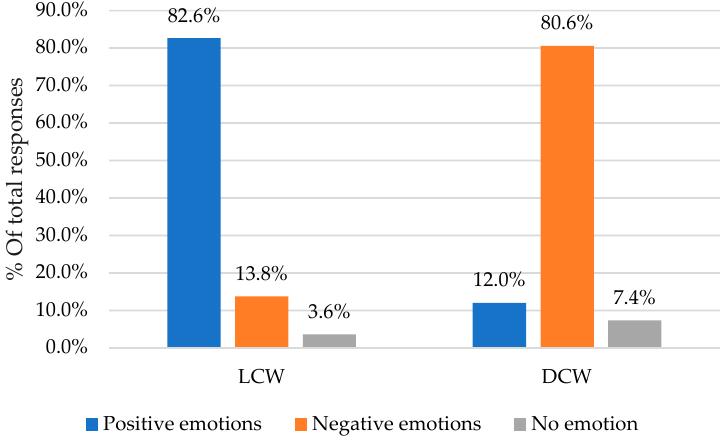
Figure 6. Percentages of total responses of positive, negative, and no emotion choices towards LCW and DCW. n = 487.